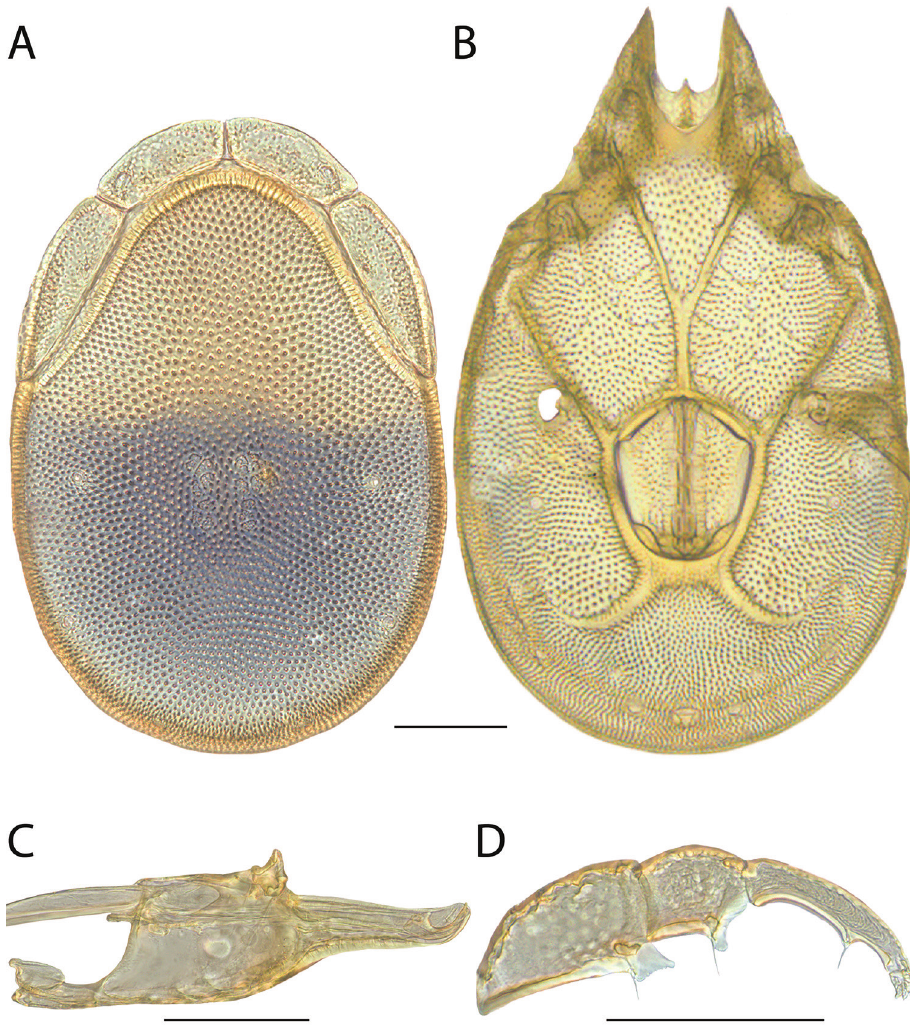
Figure 79. Torrenticola flangipalpa sp. n. female: A dorsal plates B venter (legs removed) C subcapitulum D pedipalp (setae not accurately depicted). Scale = 100